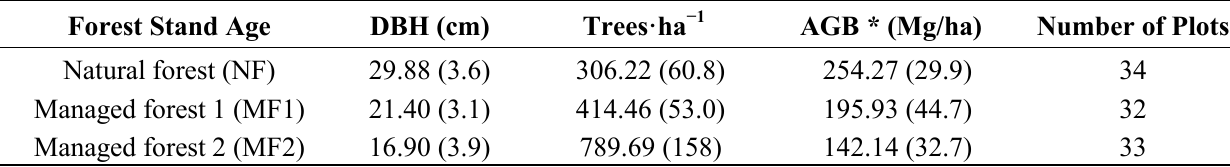
Table 2. Summary of the field plot measurements. Average values per plot are indicated. Standard deviation values are indicated inside